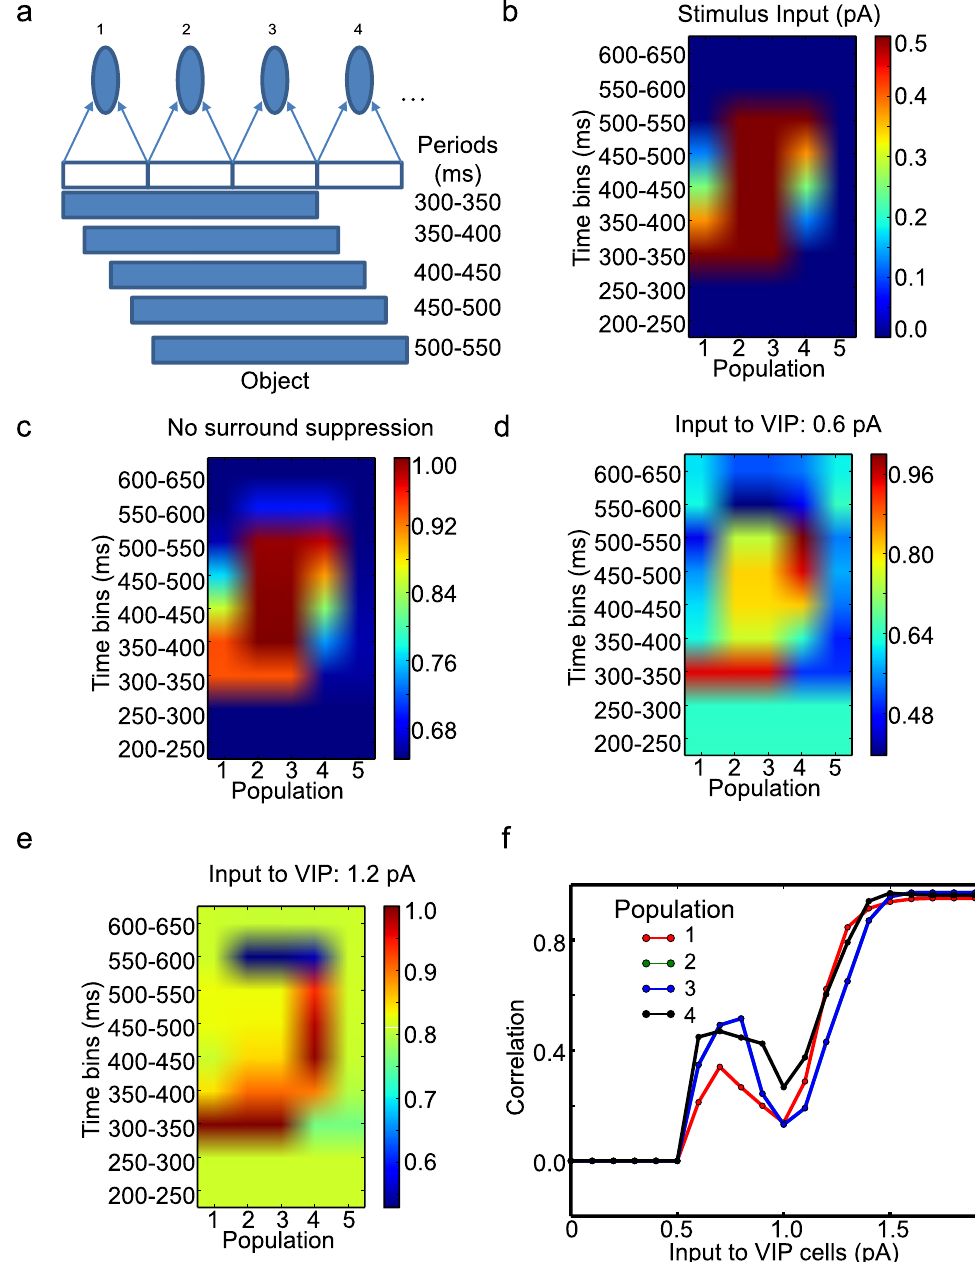
Figure 4. The effects of VIP cell depolarization on model responses to the object in motion. ( a ) Method by which we simulate the object moving over time. ( b ) Stimulus input introduced to the populations in color codes. The red indicates the maximum stimulus input 0.5 pA. The x - and y -axes represent the identity of population and time bins. ( c ) The normalized Pyr cell responses to the stimulus input shown in ( b ) when all inter-population Pyr-SST cell connections are removed. ( d and e ) The normalized Pyr cell responses with surround suppression depending on the input to VIP cells. In ( c – e ) Pyr cell responses are divided by the maximum Pyr cell responses (over all populations) during simulations. The strength of the input to VIP cells is shown above each panel. ( f ) Population specific correlations between stimulus inputs and the Pyr cell responses. As the population 2 and 3 show identical responses, only population 3 is visible in ( f